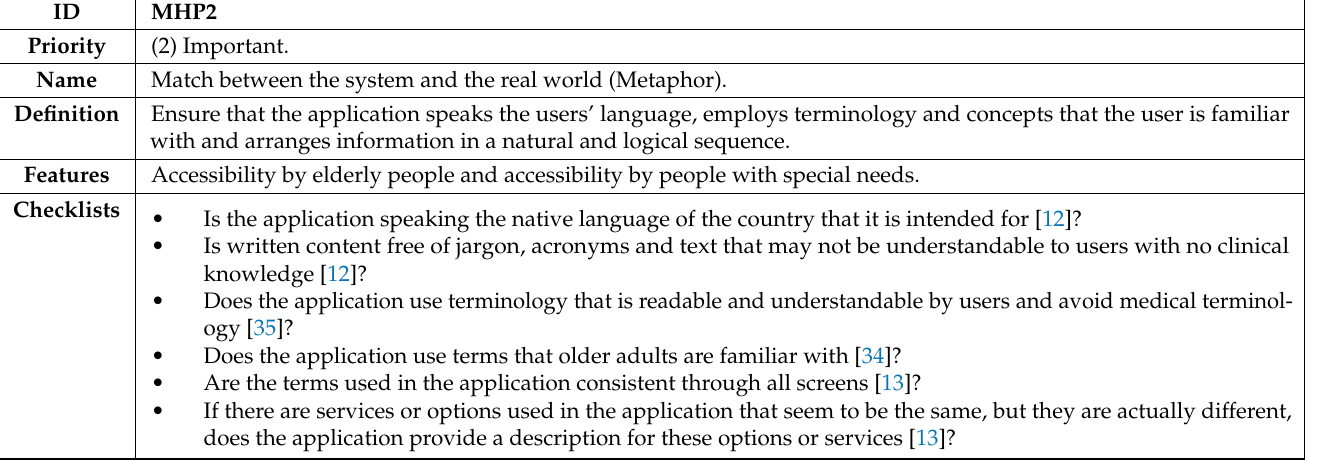
Table A2. Descriptive details of the second